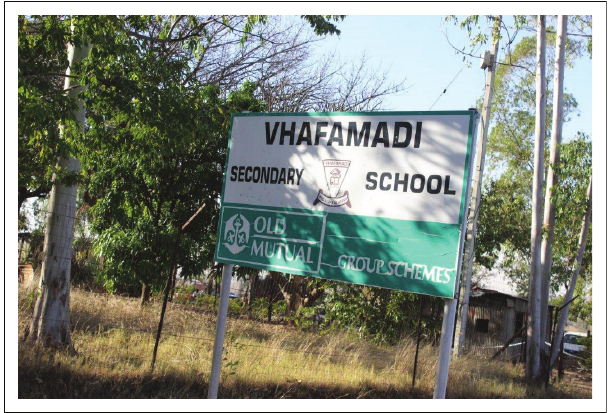
Figure 3 indicates the fire gutted Mavhina Primary School. At the back are mobile classrooms provided by the Limpopo Department of Education. Learners of Lupedze Primary School (Figure 4) were also left with no option than gathering in one room for both teaching and feeding.